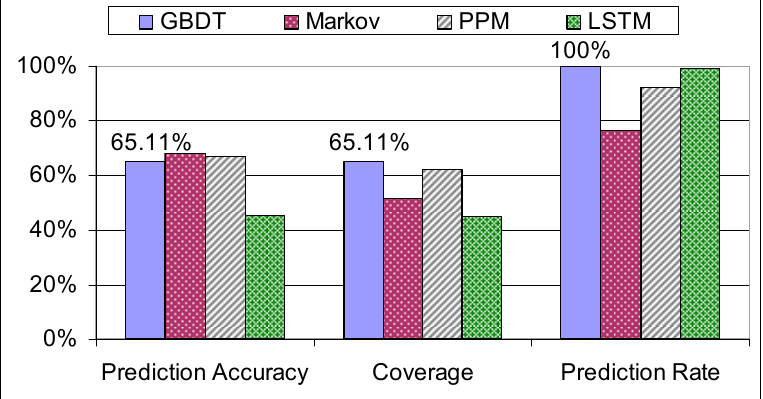
Figure 16. Comparison on the mixed dataset.